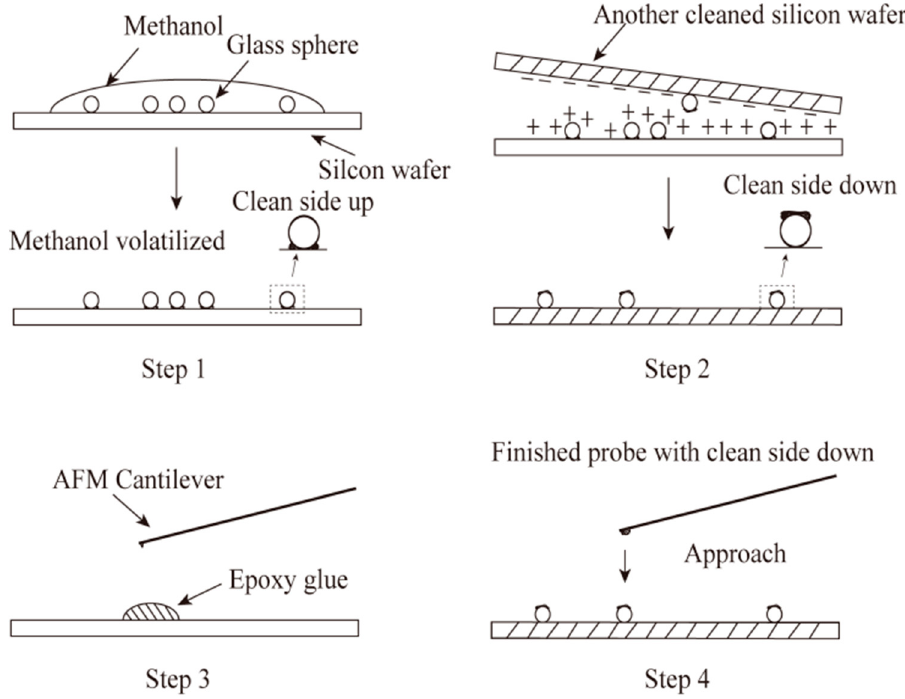
Figure 2. The preparation principle of colloidal probe